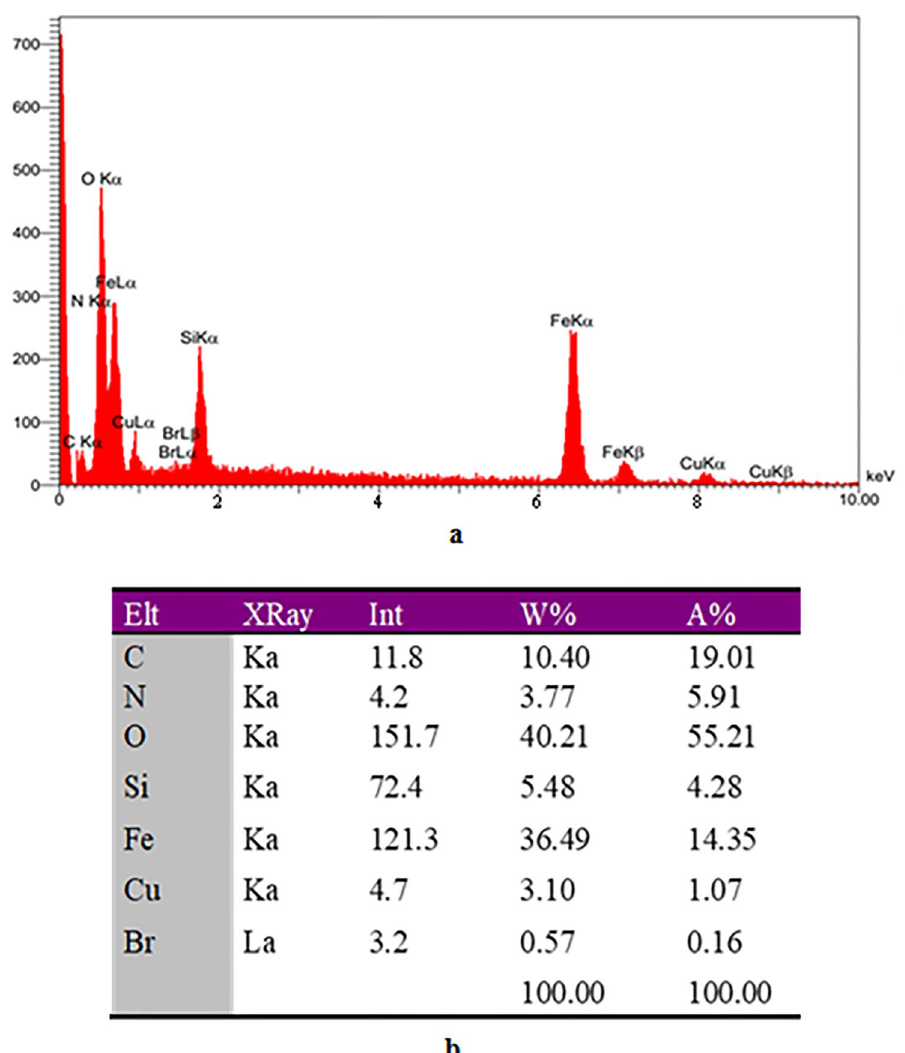
Figure 5. ( a ) EDX Spectrum and ( b ) Projected elemental composition of Fe 3 O 4 @SiO 2 -Im[Br]-SB-Cu